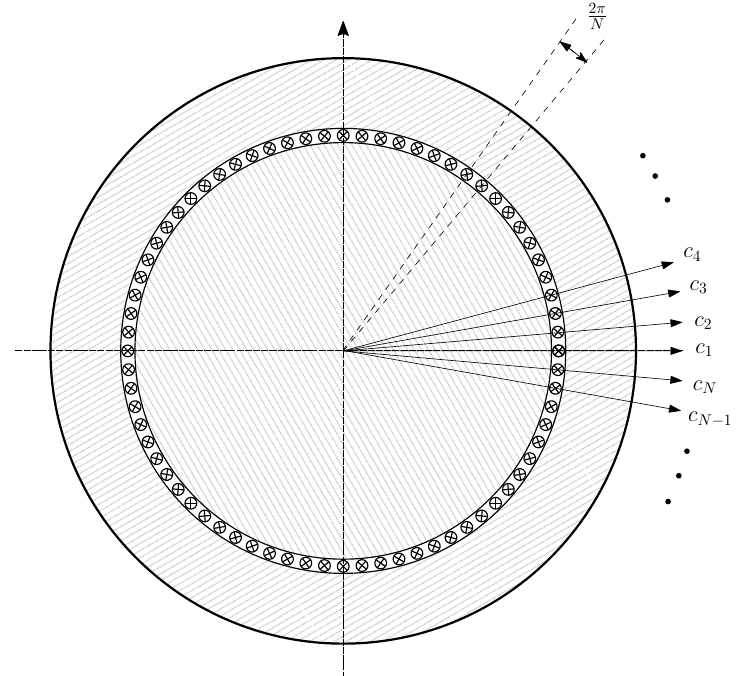
Figure 6. Elementary conductors placed in the air gap that constitute the primitive spatial network of the IM. These N conductors are considered to be disconnected, and their currents are considered to be independent